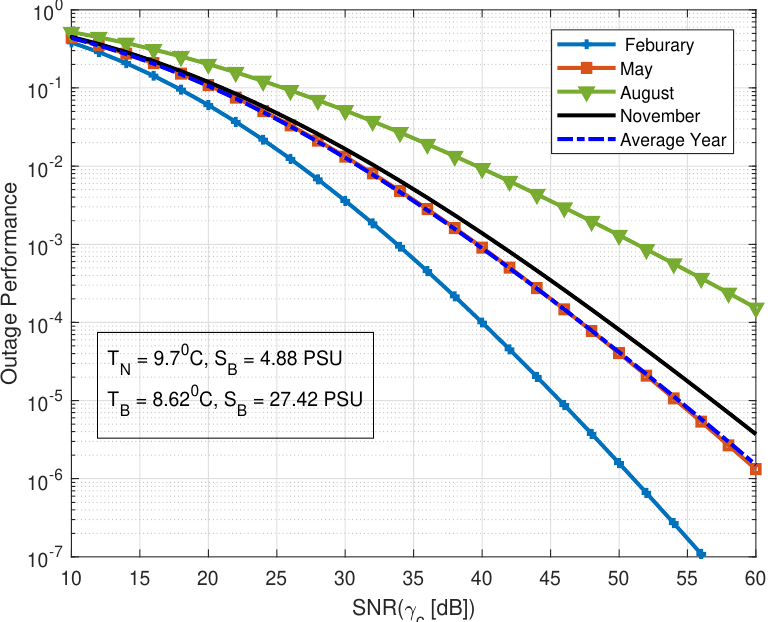
Figure 8. The outage performance of the system is depicted at the particular vertical distance of the communication setup in North ocean. The highest and minimum outage performances are depicted on different water